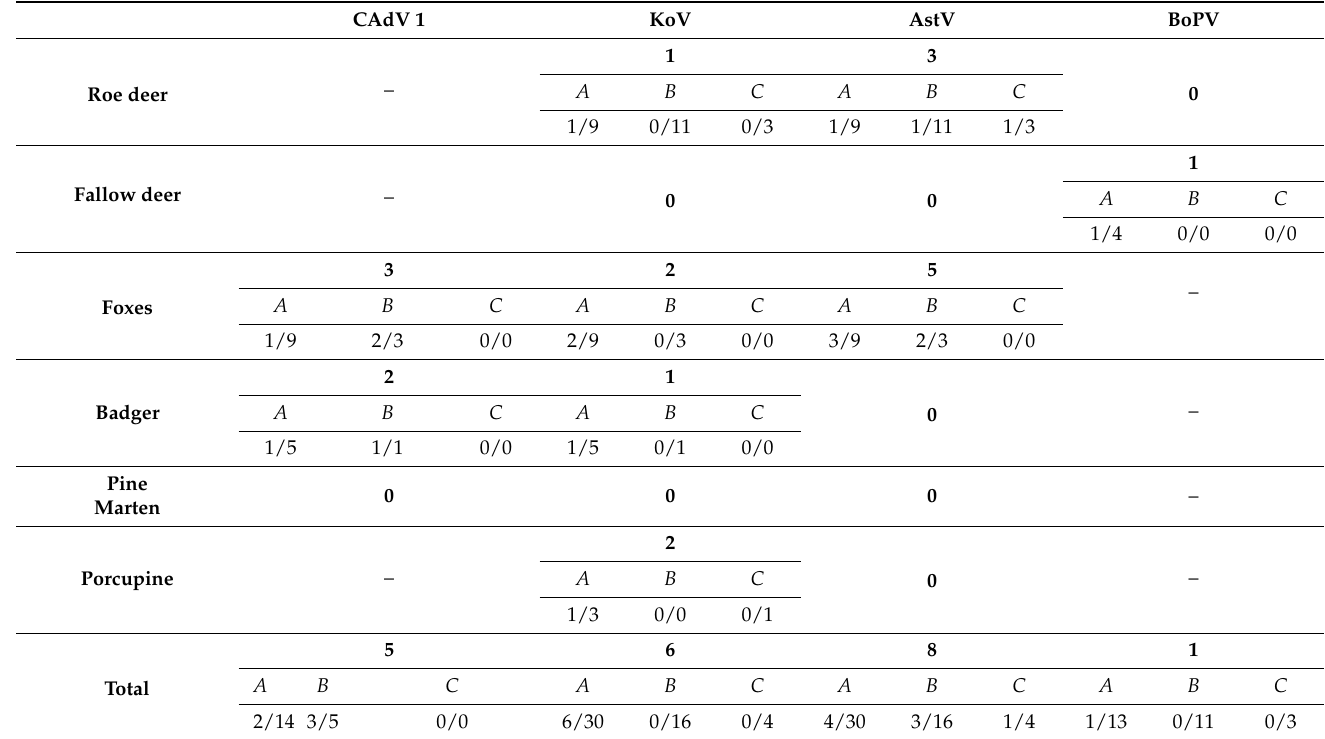
Table 4. Results of virological molecular analyses presented by viruses, species and rescue zones. A, B, and C refer to rescue